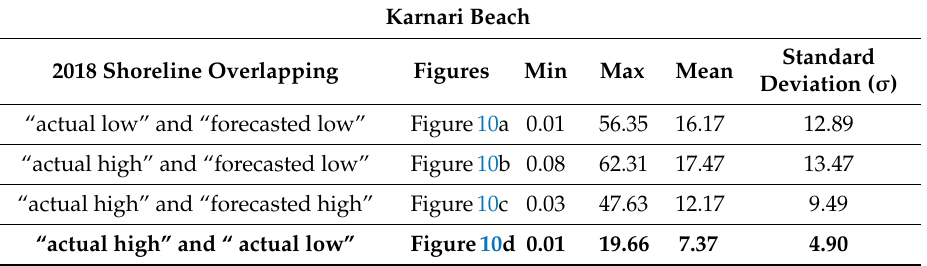
Table 3. SCE statistical rates (in